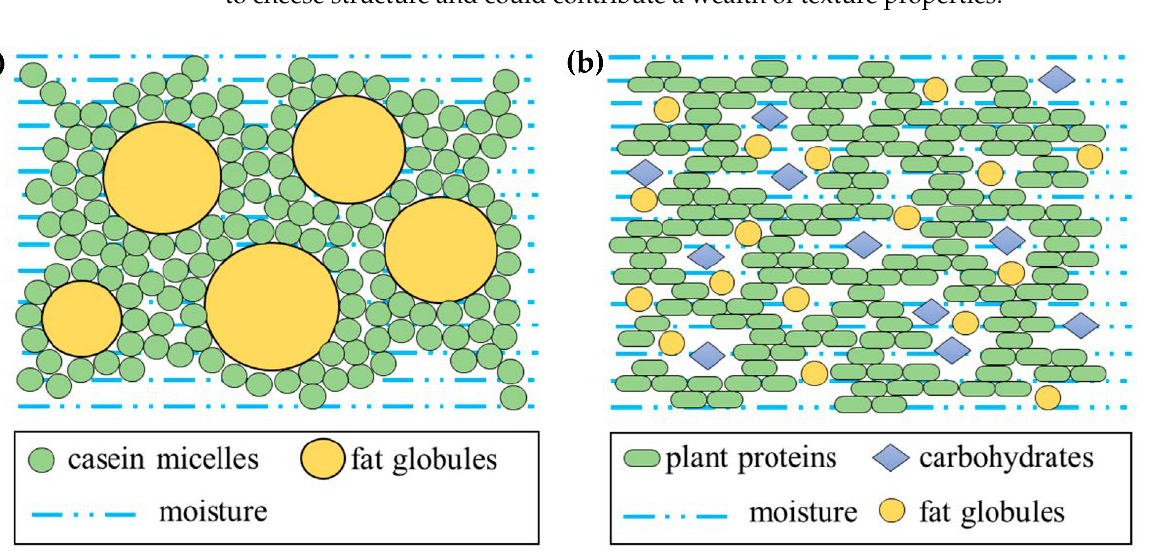
Figure 6. Comparison of the structure of the respective cheeses: ( a ) conventional milk cheese and ( b ) plant cheese.